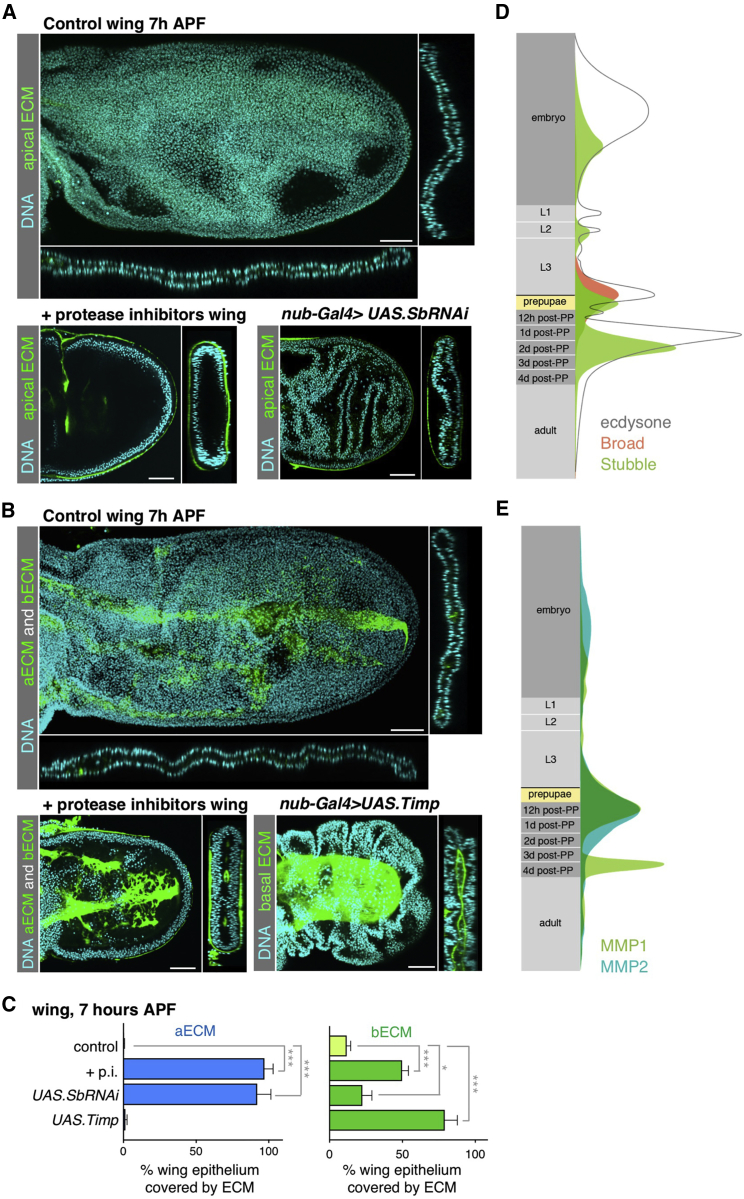
Preventing Matrix Degradation Is Sufficient to Block Elongation of the Wing(A) Cross-sections of 7 hr APF control (dp-YFP/+) (top), dp-YFP/+ wings treated ex vivo with a protease inhibitor mix (bottom left), or Stubble protease RNAi dp-YFP/+ wings (bottom right). Control wings treated with protease inhibitors and Stubble RNAi wings have not expanded and elongated at 7 hr APF, and are still covered by apical Dp-YFP even though the peripodial membrane has been released. Scale bars, 50 μm.(B) Cross-sections of 7 hr APF control (dp-YFP nub-Gal4/vkg-GFP) wings (top), control wings treated with protease inhibitors (bottom left), and Timp-overexpressing wings (vkg-GFP nub-Gal4>UAS.Timp) (bottom right). Wings treated with protease inhibitors and Timp-expressing wings fail to expand and elongate after the release of the peripodial membrane. Scale bars, 50 μm.(C) Quantification of the percentage of wing epithelium covered with apical Dp-YFP and basal Vkg-GFP in protease inhibitors treated (+p.i.), nub-Gal4>UAS.SbRNAi, and nub-Gal4>UAS.Timp wings. Timp overexpression has no effect in Dumpy degradation, and the moderate increase in Collagen IV covering the epithelial basal surface under Stubble inhibition compared with control wings is likely due to the decrease in wing surface. Average and SD are presented; n > 4 for each developmental stage. Statistically significant differences between the control and the experimental conditions are indicated (∗p < 0.05, ∗∗∗p < 0.001).(D) Schematic graph showing the timing of Stubble protease mRNA induction just following the peak of ecdysone synthesis, and expression of the Broad transcription factor mRNA at pupariation (adapted from www.flybase.org, modEnCODE Development RNA-Seq database; Graveley et al., 2011, modENCODE Consortium et al., 2010).(E) Schematic graph showing the timing of MMP1/2 protease mRNA induction at pupariation (adapted from www.flybase.org, modEnCODE Development RNA-Seq database; Graveley et al., 2011, modENCODE Consortium et al., 2010).See also Figure S1.